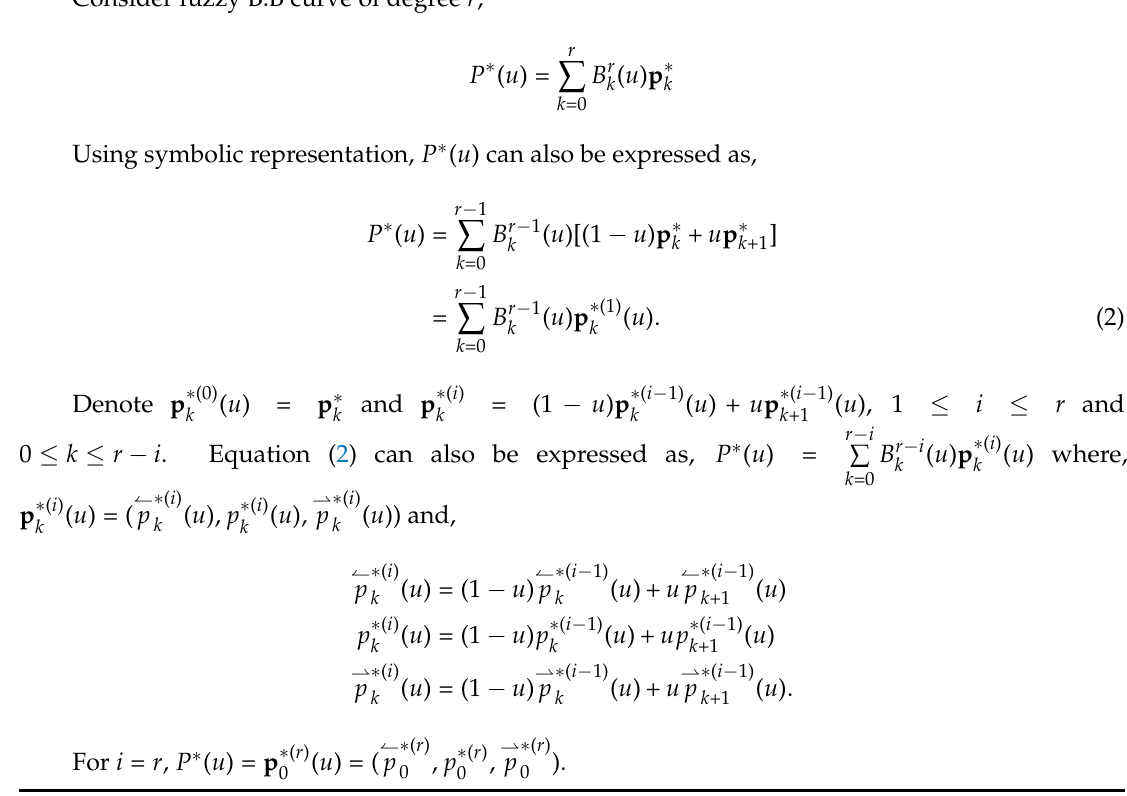
Algorithm 1. De Casteljau’s algorithm for fuzzy B.B curves